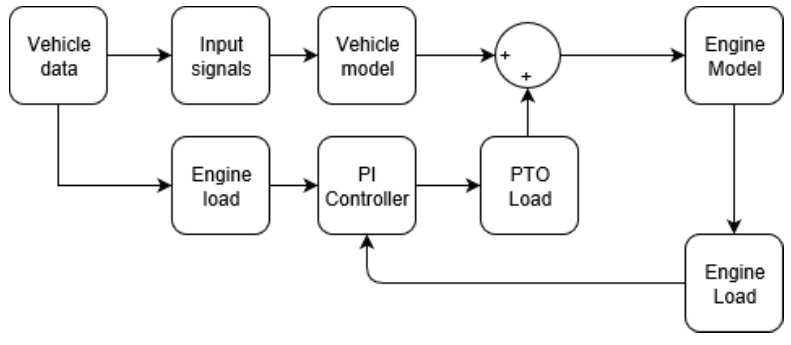
Figure 4. PTO load modeling